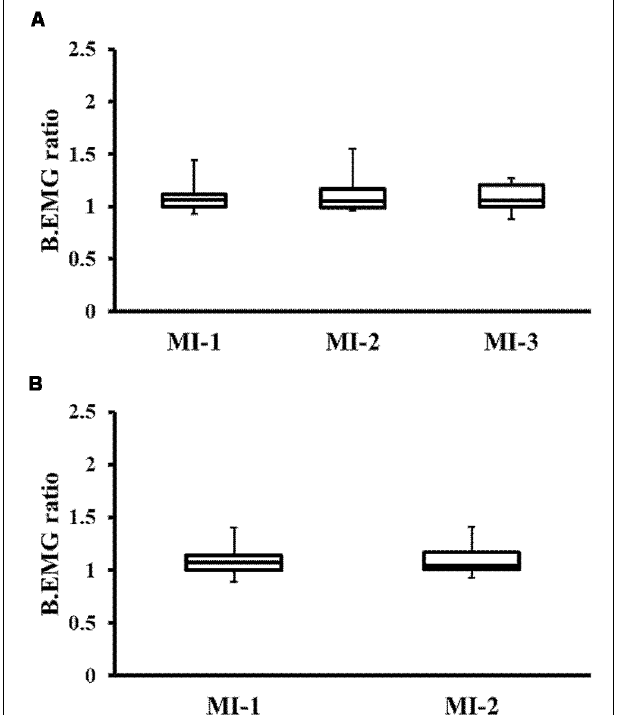
FIGURE 3 | Changes in coefficient of variation (CV) of slope. CV of slope at time points LH-1 and LH-2 for the two groups. The variability in the degree of inclination of the actual force output by the left hand decreased significantly more in the transfer training than in the control group. ∗ p < 0.05.